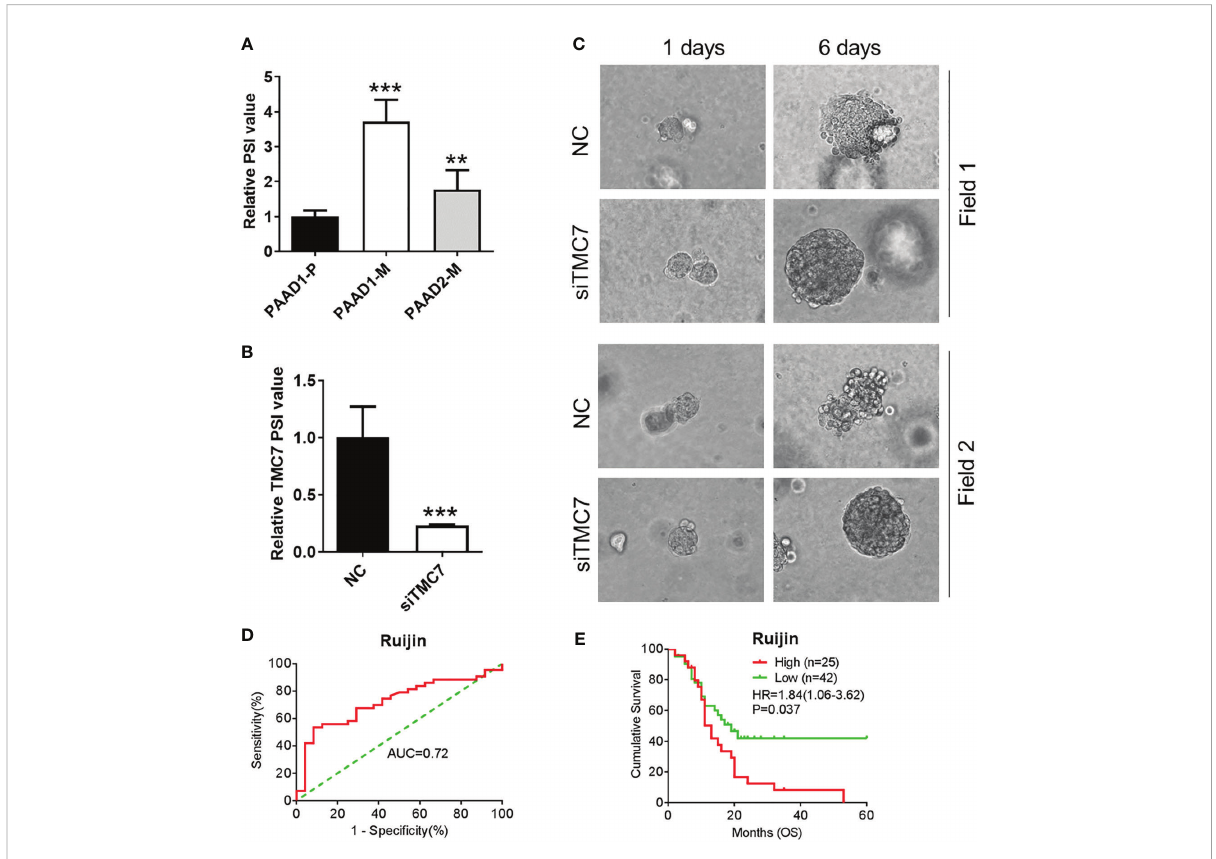
FIGURE 6 Exon 17 of TMC7 regulates invasion of PDAC-derived organoids and is signi fi cantly associated with inferior prognosis in PDAC. (A) Expression of TMC7 AS events in pancreatic cancer organoids derived from primary or liver metastatic tissues. (B) After treatment by siRNAs targeting TMC7 exon 17, RNA levels of TMC7 exon 17 and exon 16 were detected by qRT-PCR. (C) After treatment by siRNAs targeting TMC7 exon 17 for 6 days, the invasion ability of organoids was evaluated by 3D invasion assay. (D) A ROC curve was plotted to acquire optimal cutoff value to predict patients ’ overall survival. (E) Kaplan – Meier survival curves of TMC7 PSI value in PDAC. PDAC, pancreatic ductal adenocarcinoma; AS, alternative splicing; ROC, receiver operating characteristic. P value, “ ** ” 0.001-0.01; “ *** ”